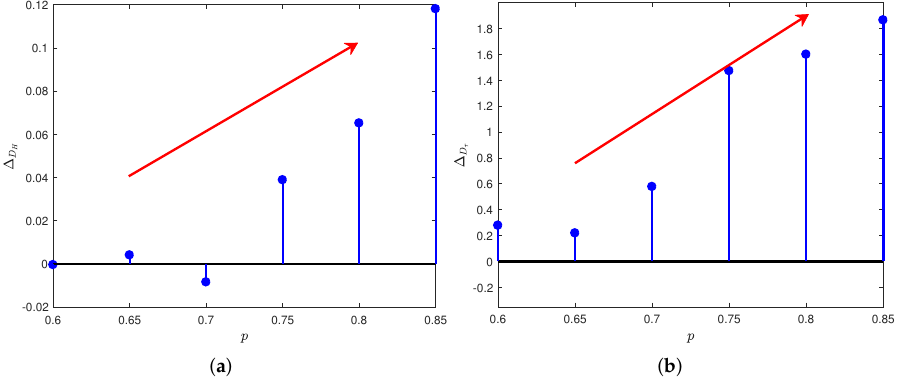
Figure 9. The difference between D H and D τ for MF-DFA and MF-S-DFA at different parameters of p : ( a ) ∆ D and ( b ) ∆ D H τ